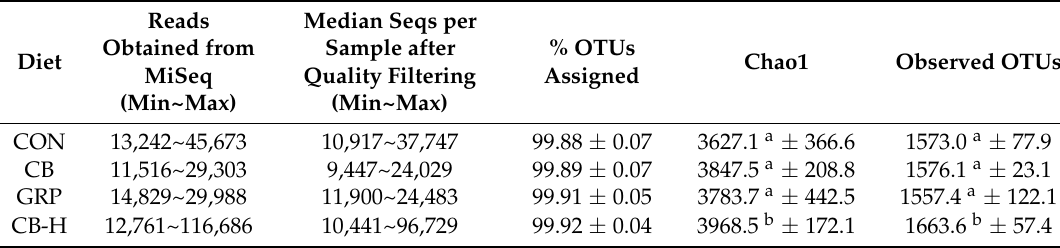
Table 4. Analysis of rat cecal microbiota following four days of treatment diets; Study 2 1 .